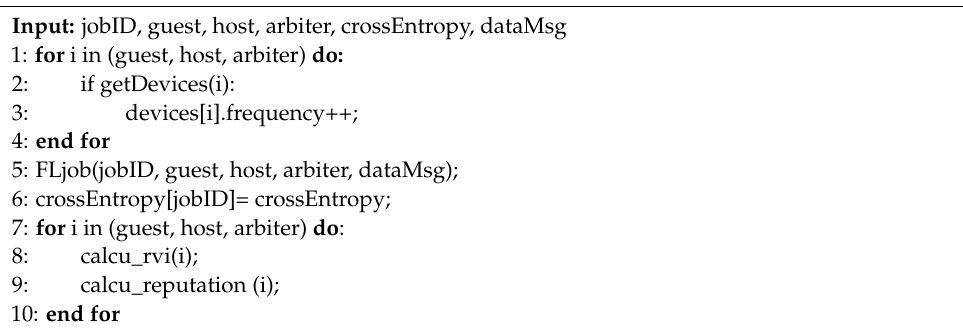
Algorithm 3 Job audit and reputation update